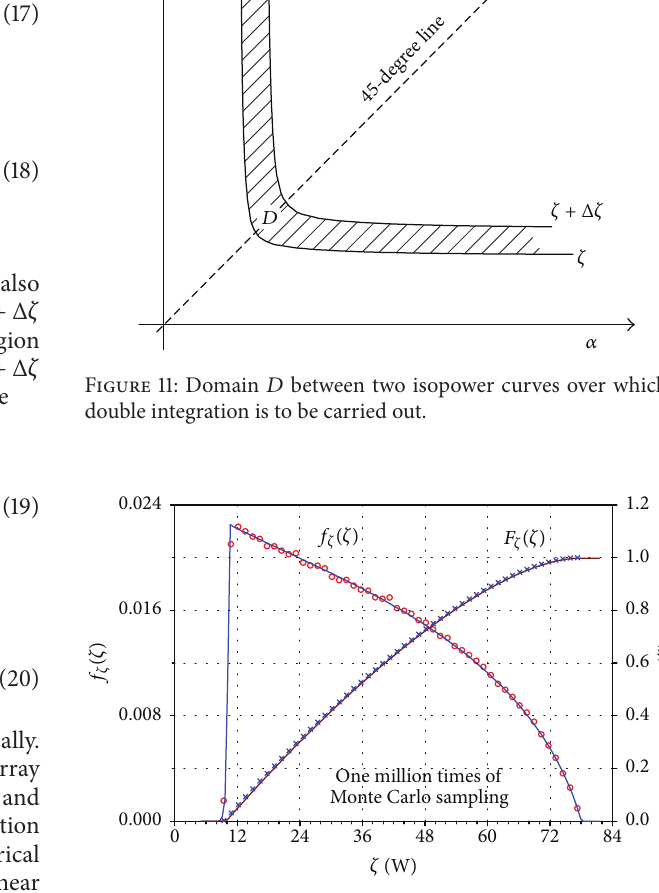
Figure 12: pdf and CDF of 𝜁 obtained from the analytical method (curves) and the MC simulations (scattered